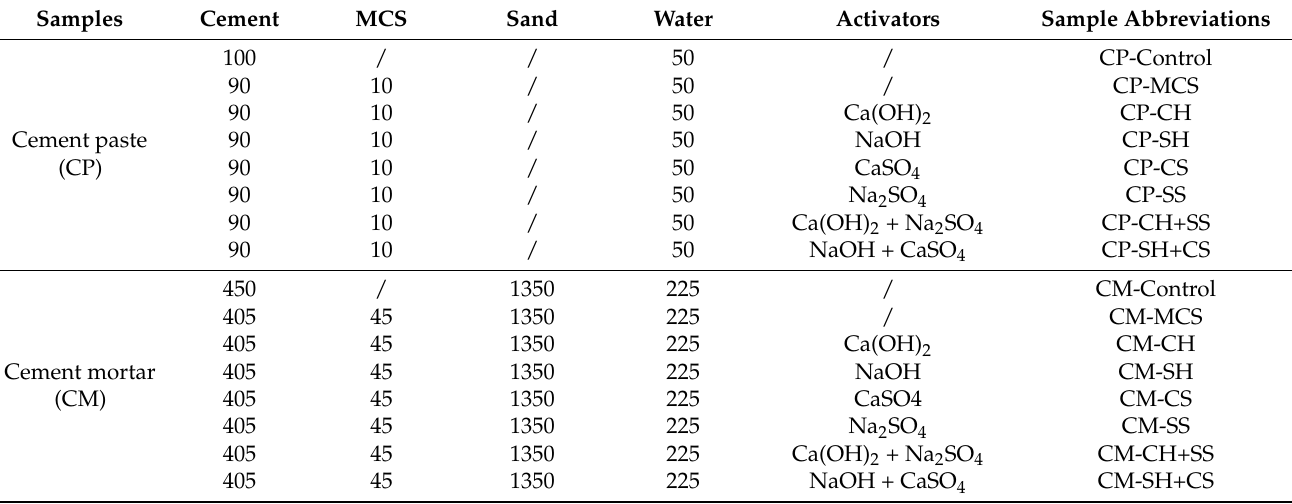
Table 5. Mixture ratios of samples (g).